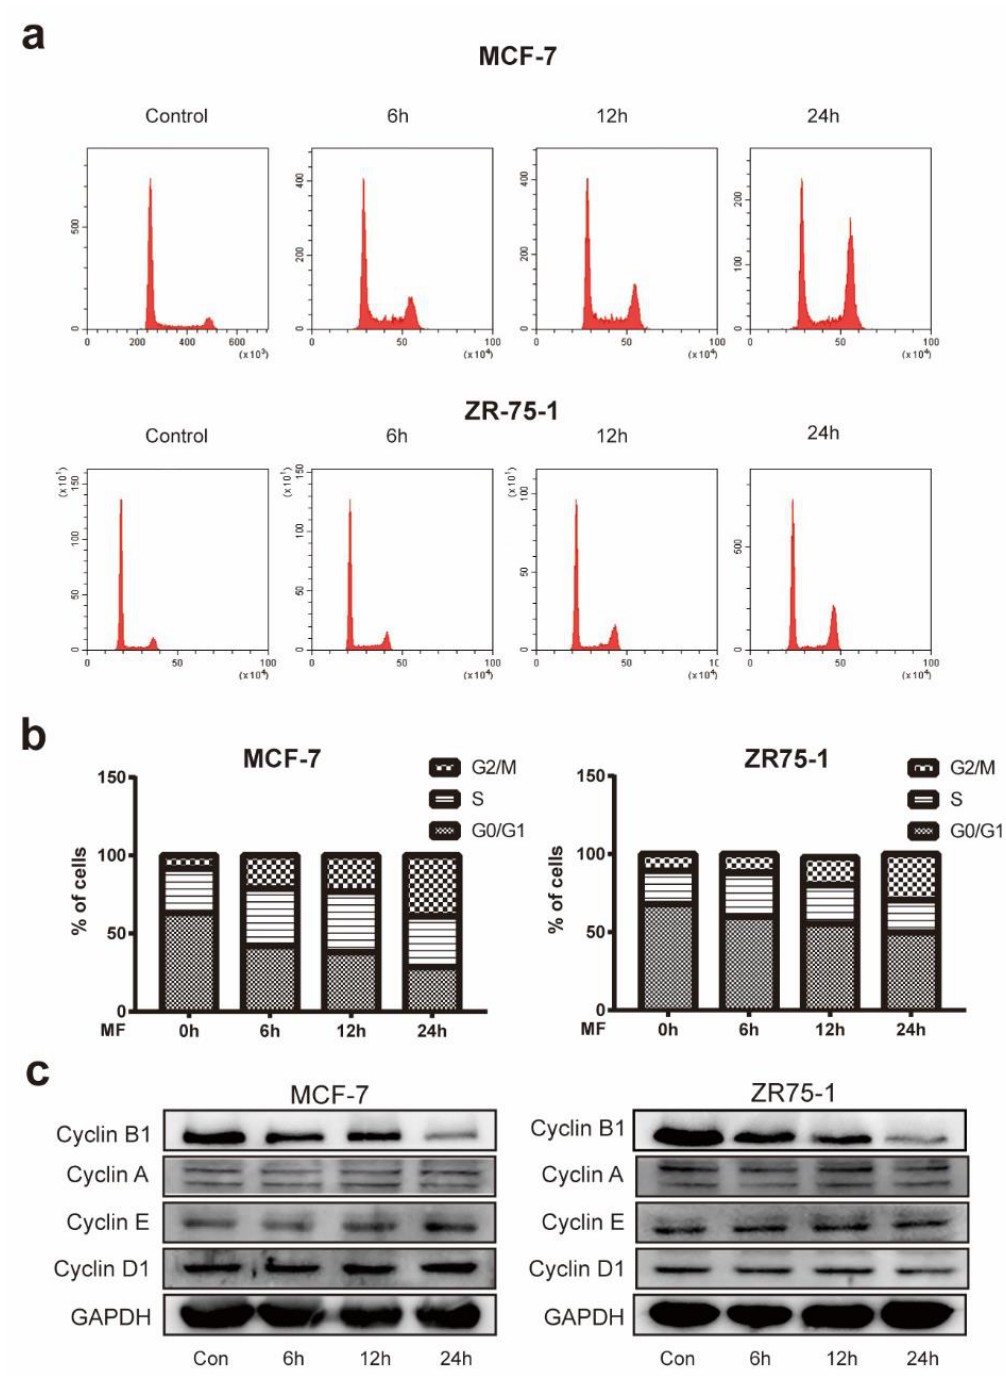
Figure 3. Effects of MF on cell cycle distribution. ( a ) Representative flow cytometry results evaluating the numbers of MCF-7 and ZR-75-1 cells during the G0-G1 / S / G2-M phase in both the control and experimental groups treated by MF. ( b ) Histograms showing the percentage of MCF-7 and ZR-75-1 cells in G0-G1, S or G2-M phase in the control and treatment groups with various exposure times to MF. ( c ) Representative western blot results showing the expression level of Cyclin B1, Cyclin A, Cyclin E and Cyclin D1 in MCF-7 and ZR-75-1 cells following exposure in MF for the designated time. In addition, GAPDH was used as a reliable internal control. Data are presented as the mean ± standard deviation (SD); n = 3; * p < 0.05, ** p < 0.01.